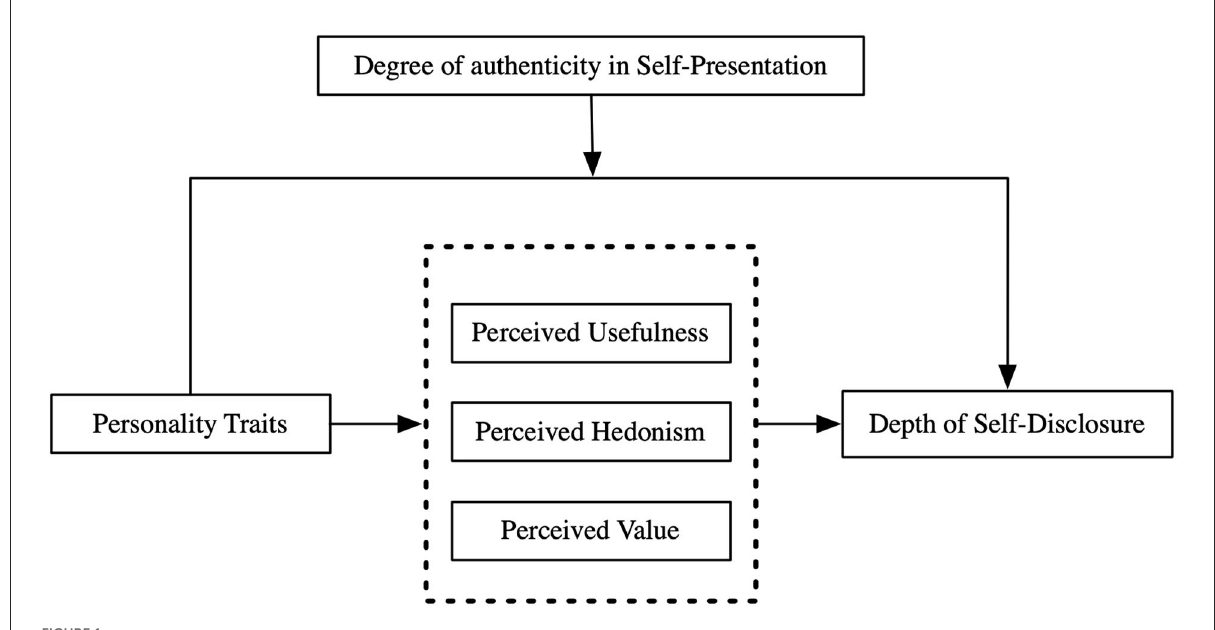
FIGURE1 The research